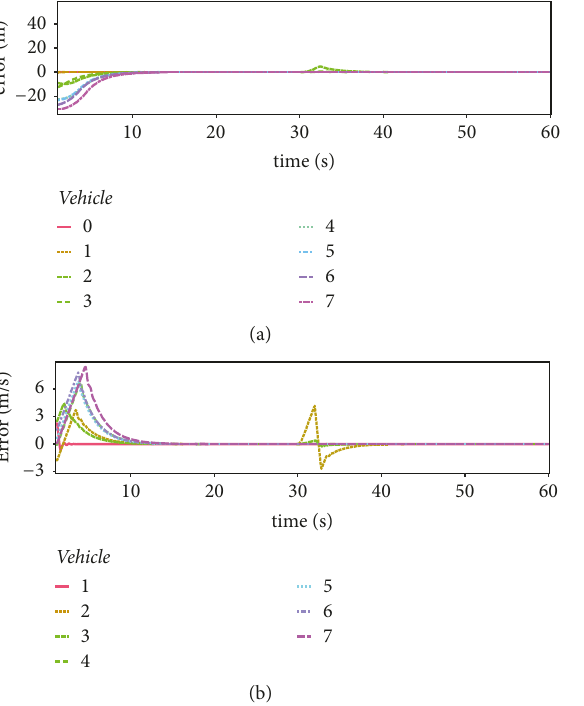
Figure 5: Platoon performance for the initial scenario under spoofing attack: (a) the position error 𝑥 𝑖 (𝑡) − 𝑥 0 (𝑡) + 𝑖 ⋅ 𝑠 ; (b) the speed error V 𝑖 (𝑡) − V 0 (𝑡) .